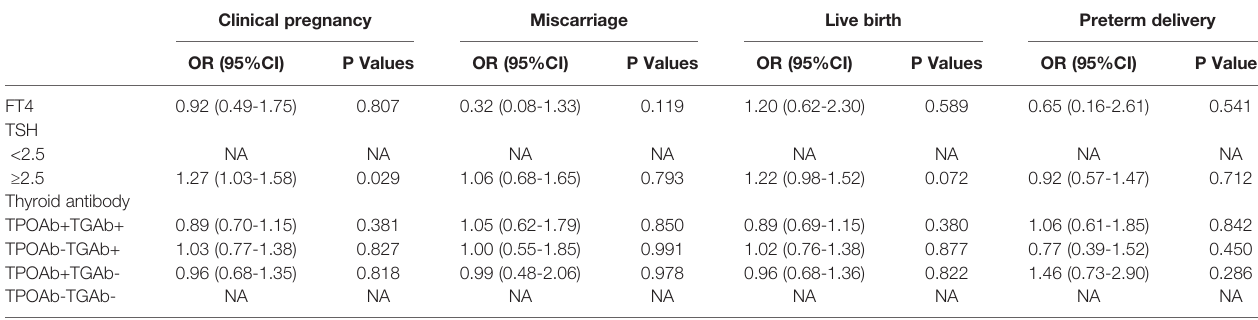
TABLE 5 | Logistic regression analysis of factors associated with pregnancy outcomes.